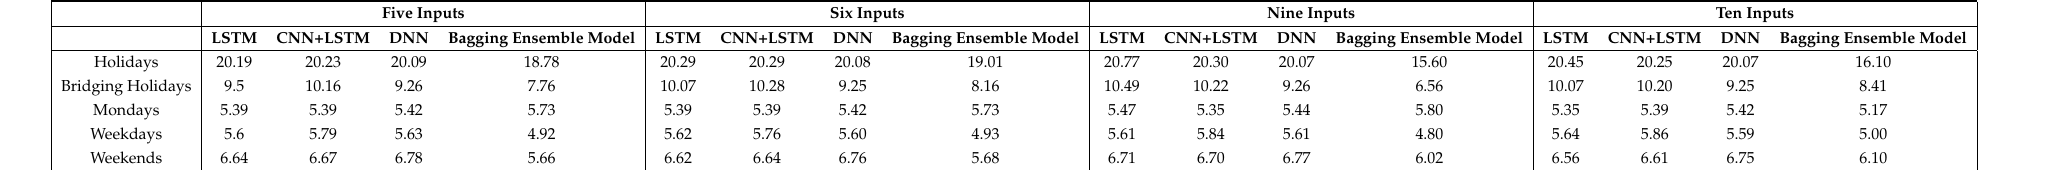
Table 6. Average MAPE for Five Categories with Different Input Features in